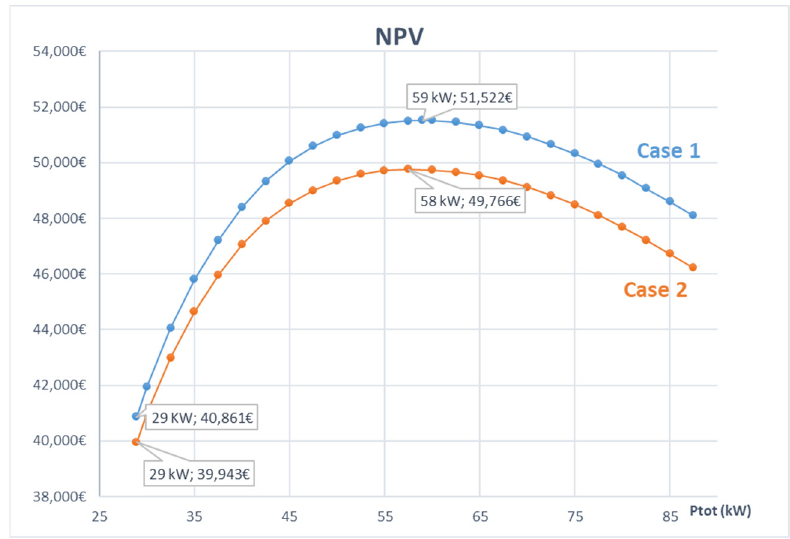
Figure 3. NPV relationship with total installed power .